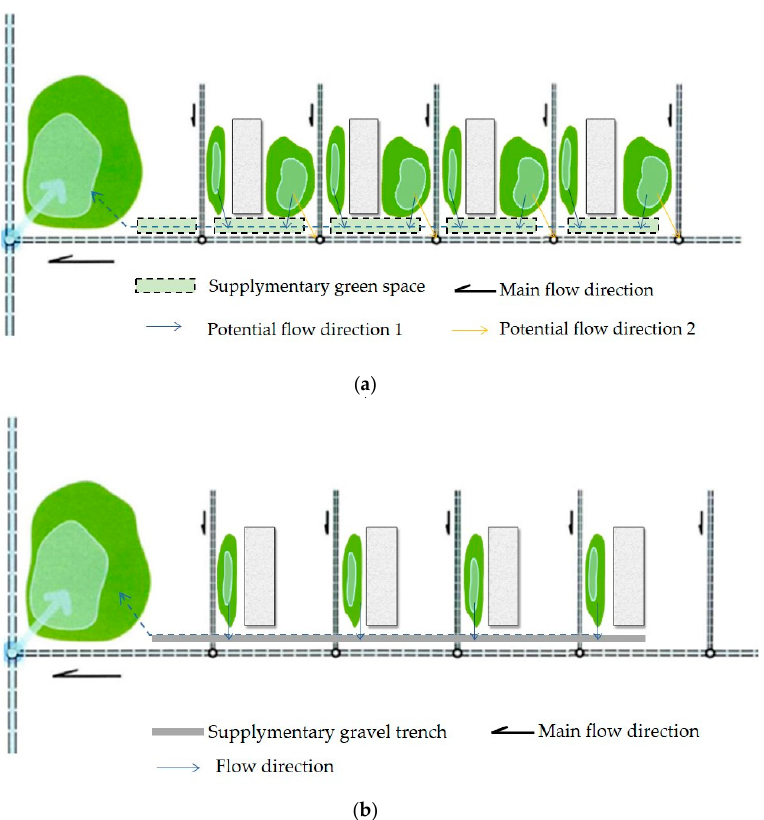
Figure 12. Optimization strategies for different preconditions of residential areas: ( a ) schematic diagram of the strategy focusing on guiding runoff and centralized regulation and storage; ( b ) schematic diagram of the strategy based on dispersion infiltration and source treatment.